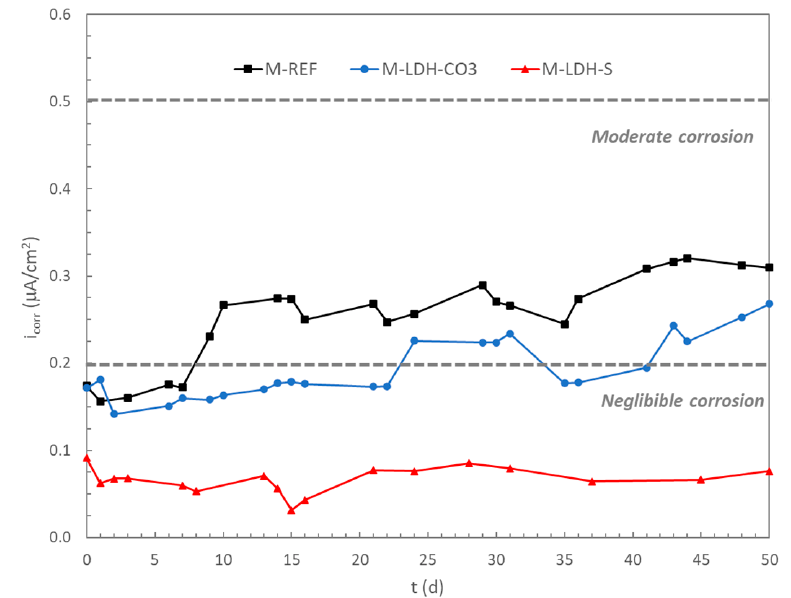
Figure 9. Evolution of the corrosion current density for the three studied reinforced mortars during the corrosion stage (exposure to chloride action).